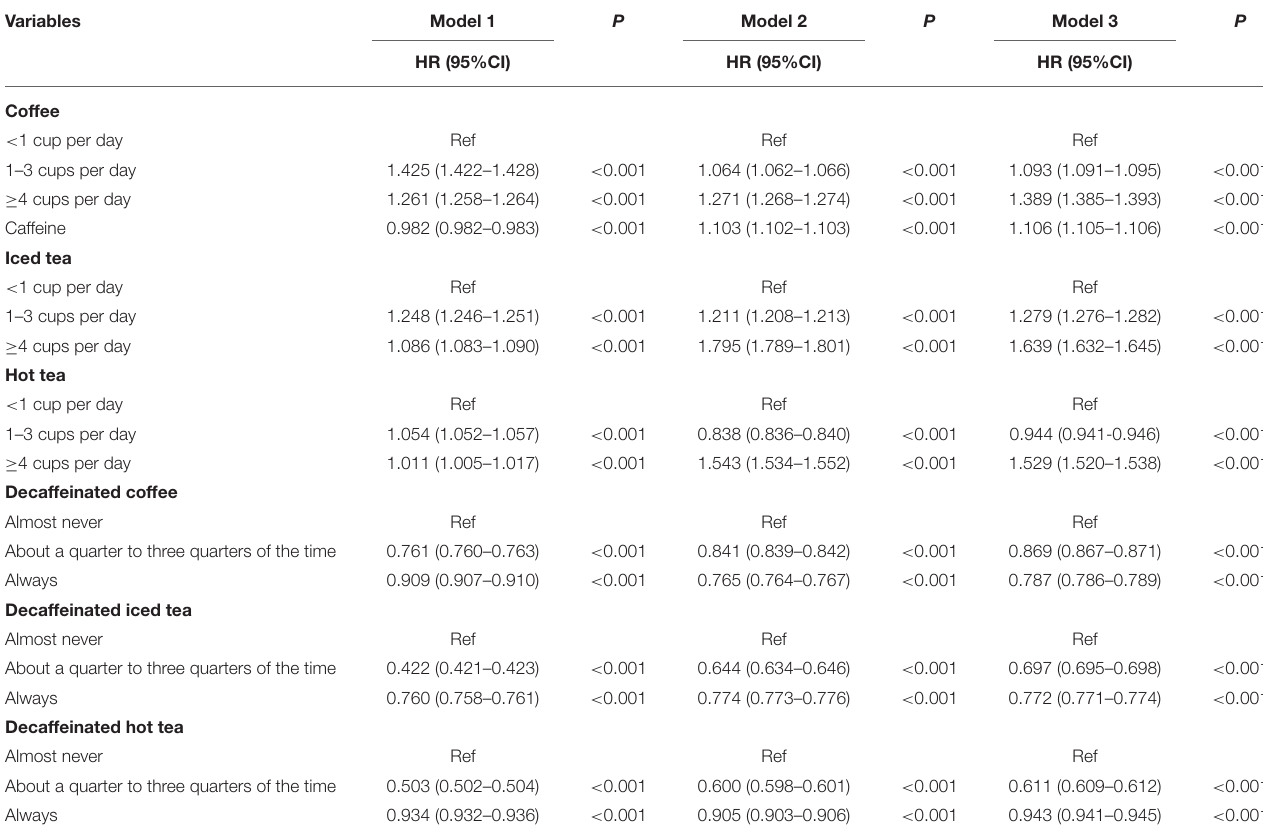
TABLE 2 | The related factors with the risk of the all-cause death in CVD population.